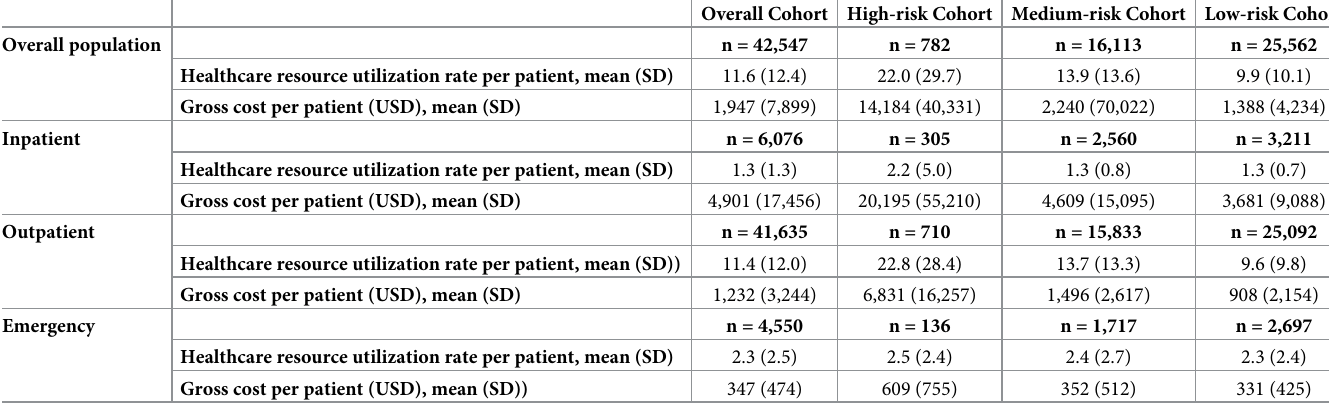
cause healthcare costs was observed in the post-pneumonia period, as compared to the costs incurred during the year before the first pneumonia episode (mean cost: 1,327 USD). Among the risk cohorts, both the highest mean number of claims and the associated costs were noted for patients in the high-risk cohort (mean HCRU claims = 22.0 per patient; mean cost = 14,184 USD). On the other hand, the mean number of pneumonia related HCRU claims and the associated costs per patient were 2.0 and 1,305 USD, respectively (Table 4). The mean number of pneumonia-related HCRU claims did not vary across the risk cohorts (mean num- ber of claims: high-risk = 1.9 per patient, medium-risk = 2.2 per patient and low-risk = 1.9 per patient), but the associated mean costs per patient for the high-risk cohort (10,207 USD) was about 8–11 times higher compared to the mean costs per patient for the medium-risk (1,283 USD) and the low-risk (882 USD) cohorts. The mean all-cause and pneumonia-related costs were largely attributed to the claims for inpatient visits in overall and in each of the risk cohorts (Tables 3 and 4). A large proportion of Table 4. Healthcare resource utilization and healthcare cost per patient (pneumonia-related claims) during 12-month follow-up (patients having at least one claim for pneumonia during 12-month follow-up period were included in the analysis; Dubai Real-World Claims Database, 2014 to 2019). Overall Cohort High-risk Cohort Medium-risk Cohort Low-risk Cohort Overall population n = 14,254 n = 387 n = 6,021 n = 7,846